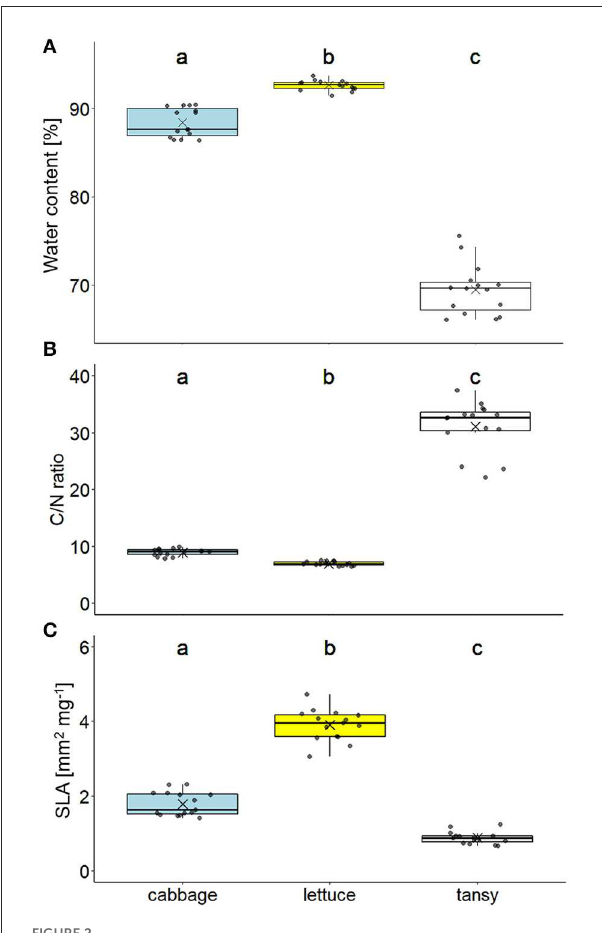
FIGURE2 Leaf quality traits of different food plant species (cabbage: Brassica rapa ; lettuce: Lactuca sativa ; tansy: Tanacetum vulgare ) with (A) water content, (B) carbon-to-nitrogen (C/N) ratio, and (C) specific leaf area (SLA; n = 15 per plant species). Box plots show the means (as crosses), medians (horizontal lines) and interquartile ranges (IQR; boxes), the whiskers extend to the most extreme values with max. 1.5 times the IQR. Individual values are plotted as dark circles. Statistical analyses were done with Kruskal–Wallis tests followed by pairwise Mann–Whitney U -tests. Significant differences ( p < 0.05) are indicated by different lowercase